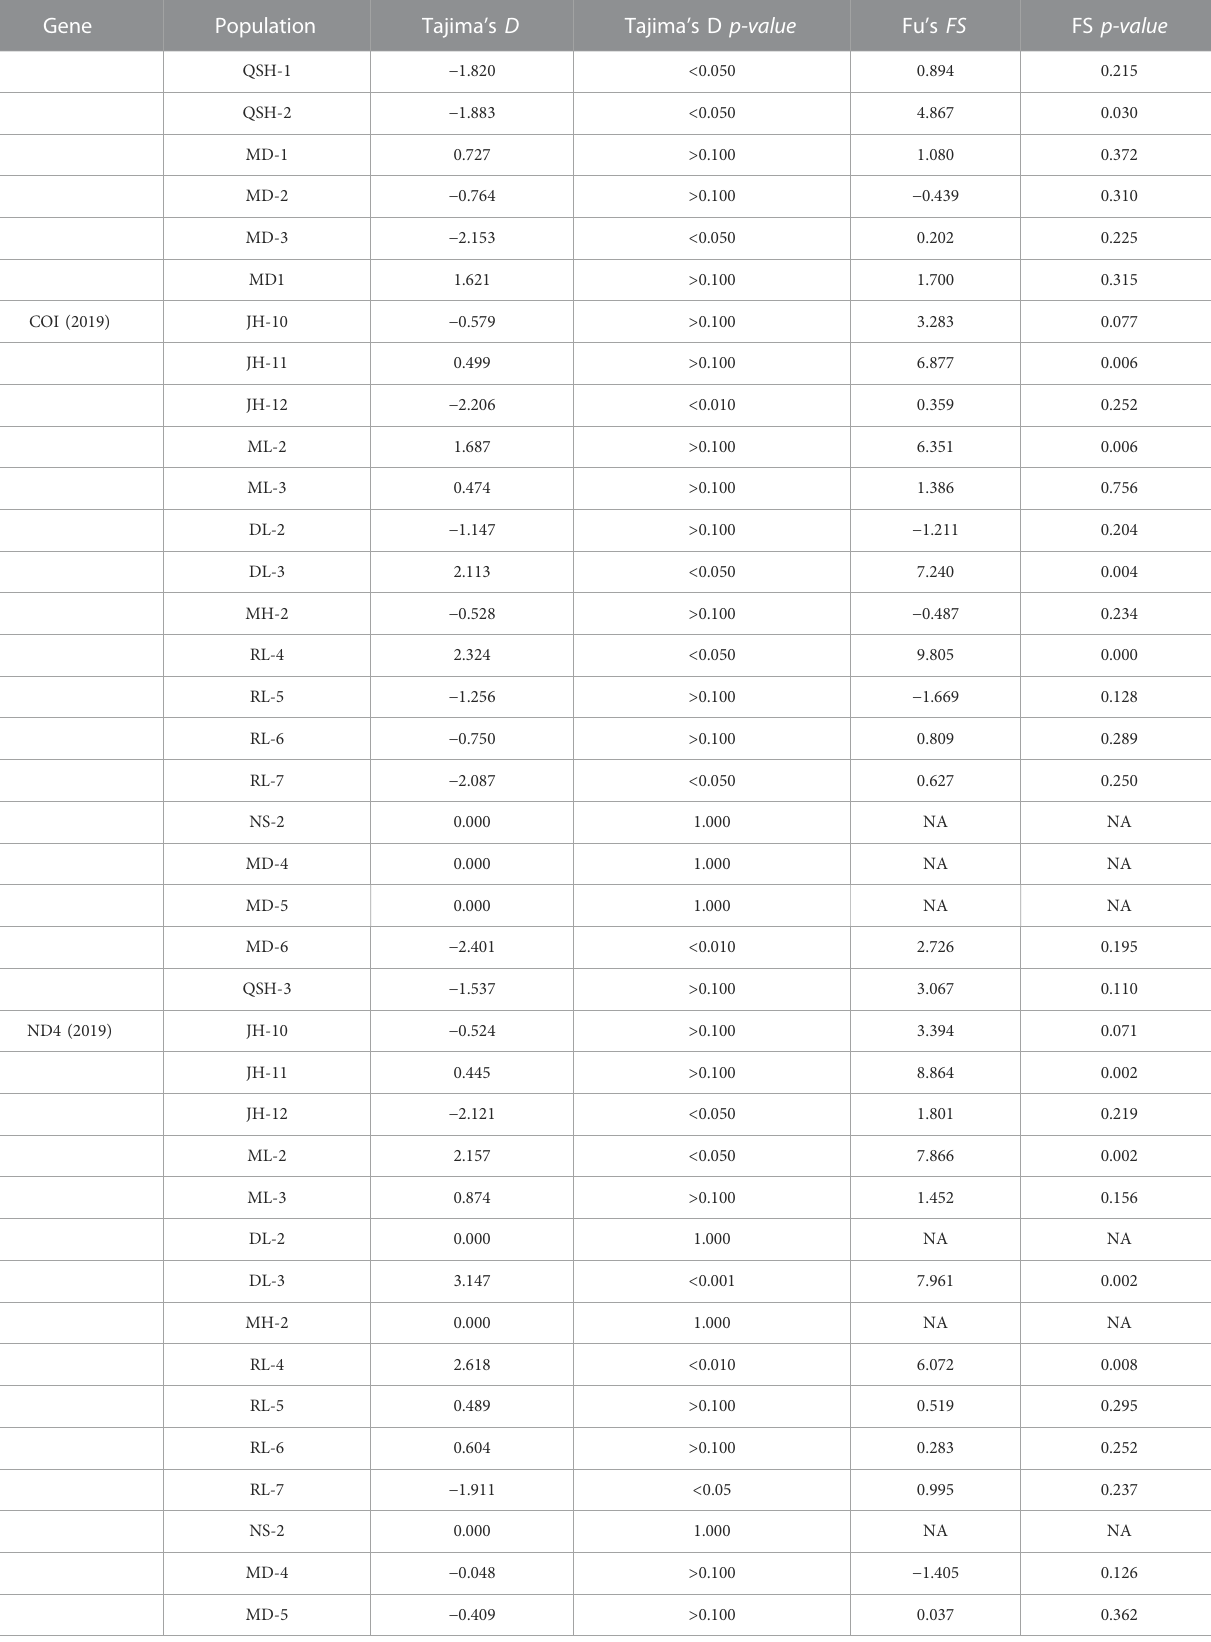
TABLE 7 ( Continued ) Neutrality test of 22 populations and 17 populations based on mtDNA in 2019, 2020.